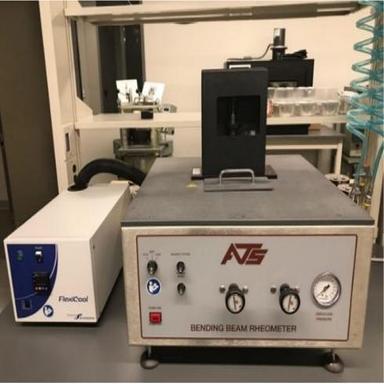
BBR test equipment at MAPIL.